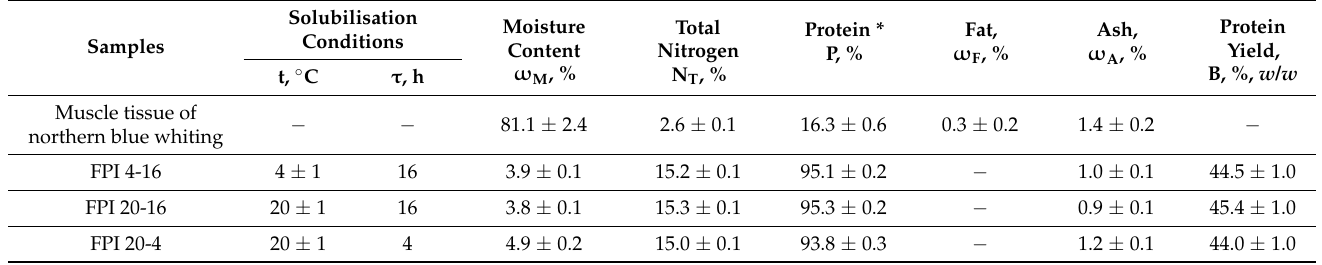
Table 1. Chemical composition of raw material and FPIs obtained under different temperatures and duration of alkaline